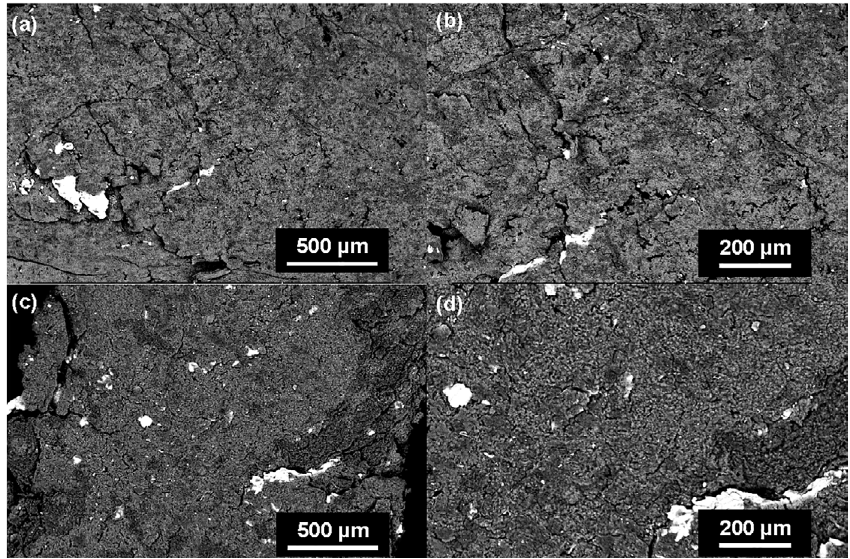
Figure 5. BSE-SEM micrographs (25 kV/10.1 mm - work distance/3.0 - spot) for samples of Mg-8 mol% Fe, with the LCNT morphology processed by ECR + ARB after 3 cycles of hydrogen absorption and desorption: (a, b) after absorption; (c, d) after desorption